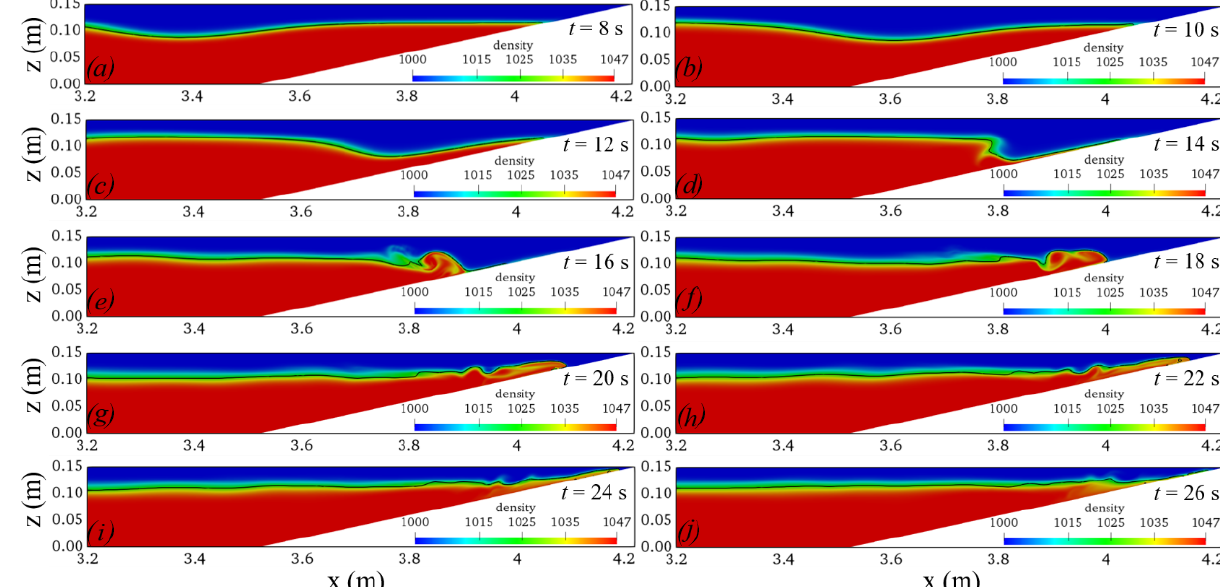
Geosci. Model Dev., 15, 105–127, 2022